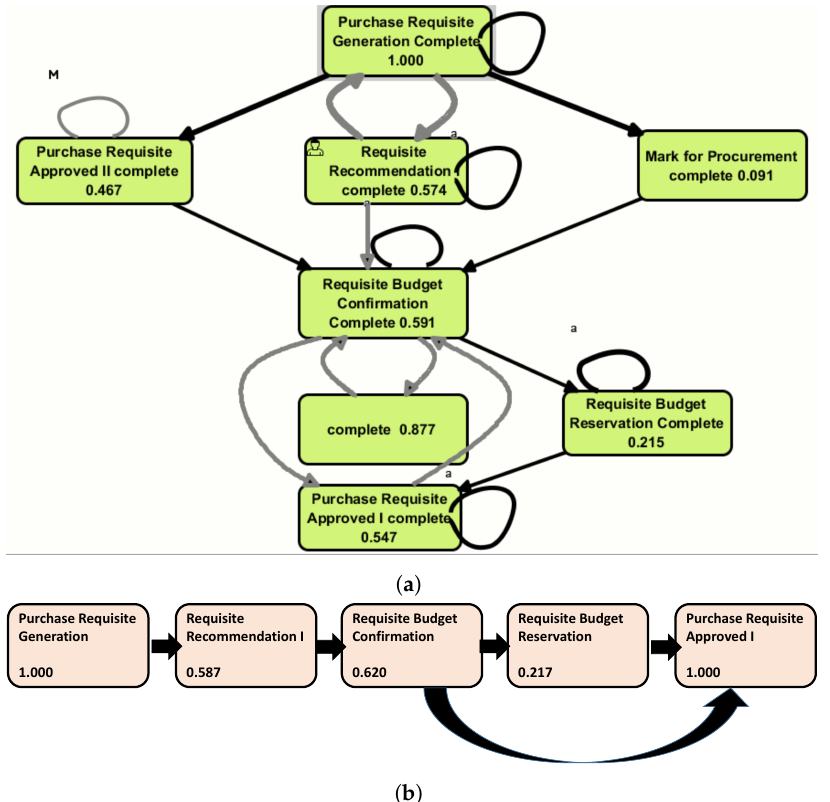
Figure 9. ( a ) Mined model generalized by fuzzy miner on original data and ( b ) Petri net generated by fuzzy miner on refined data.